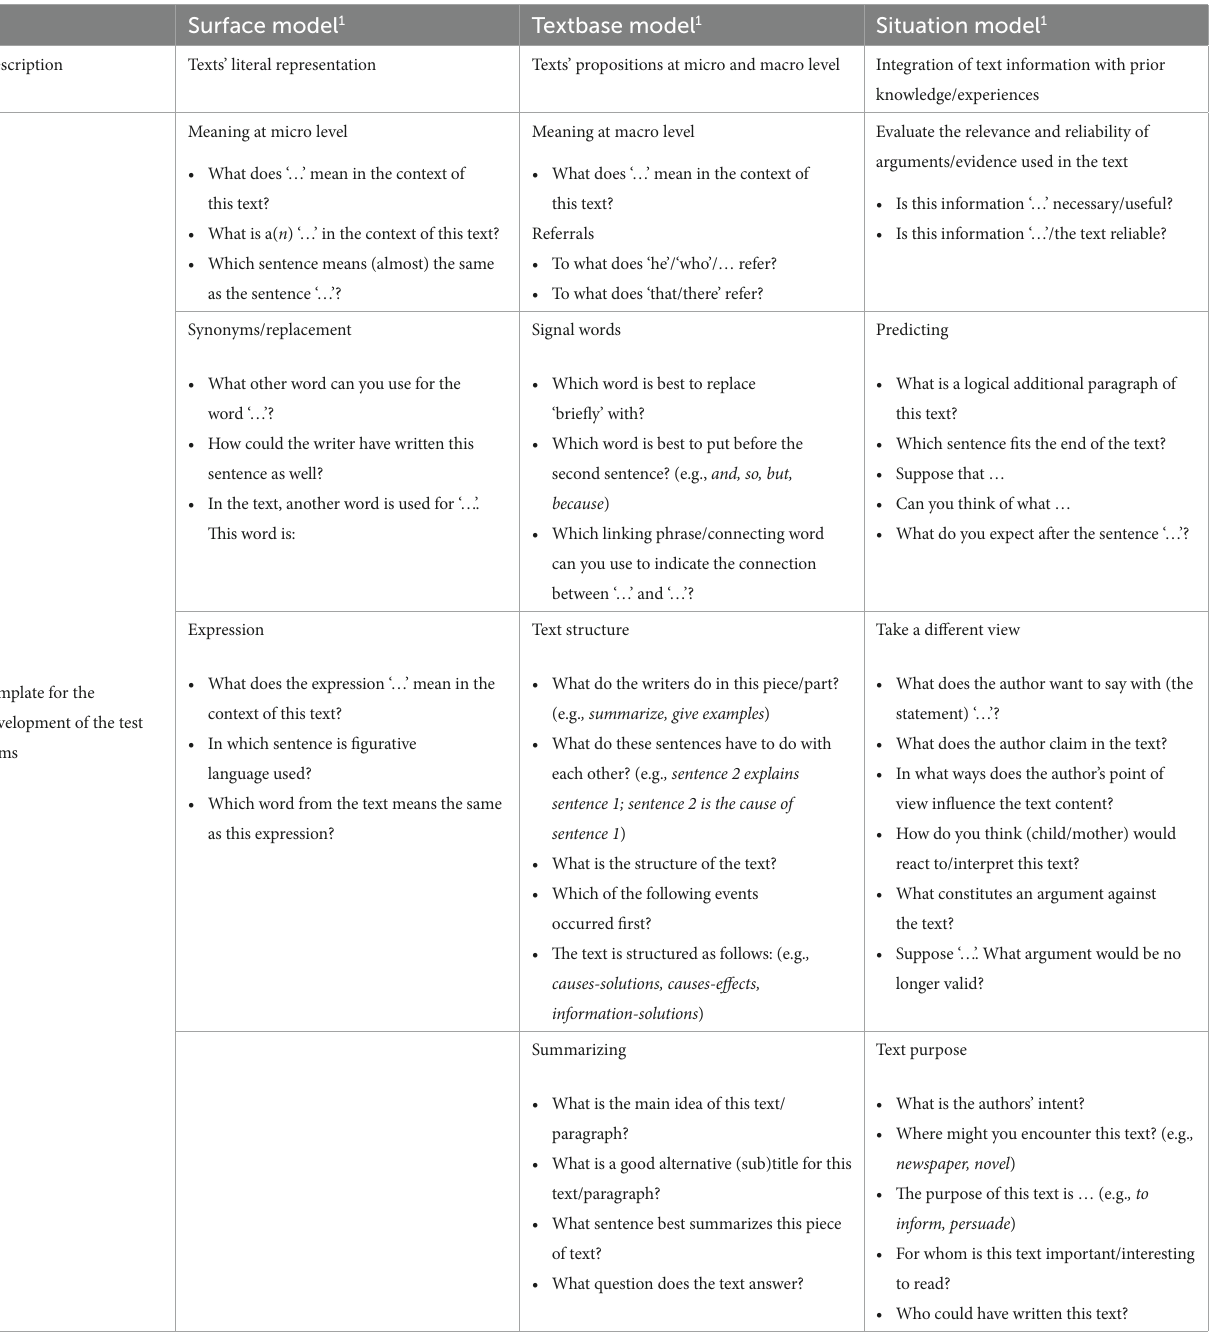
TABLE 1 Template of possible questions for each reading comprehension